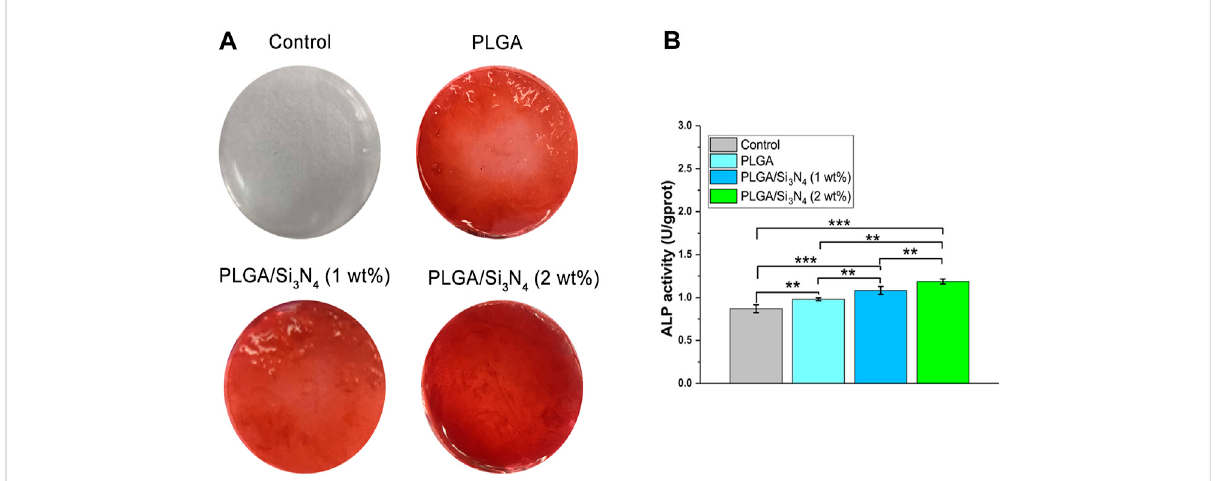
FIGURE 5 Nano fi ber scaffolds supported osteogenic differentiation. (A) ARS staining of the nano fi ber scaffolds at 7 days. The ARS solution stains calcium deposits red, with darker red indicating more calcium deposits. (B) ALP activity assay at 7 days for the nano fi ber scaffold, PLGA/Si 3 N 4 (1